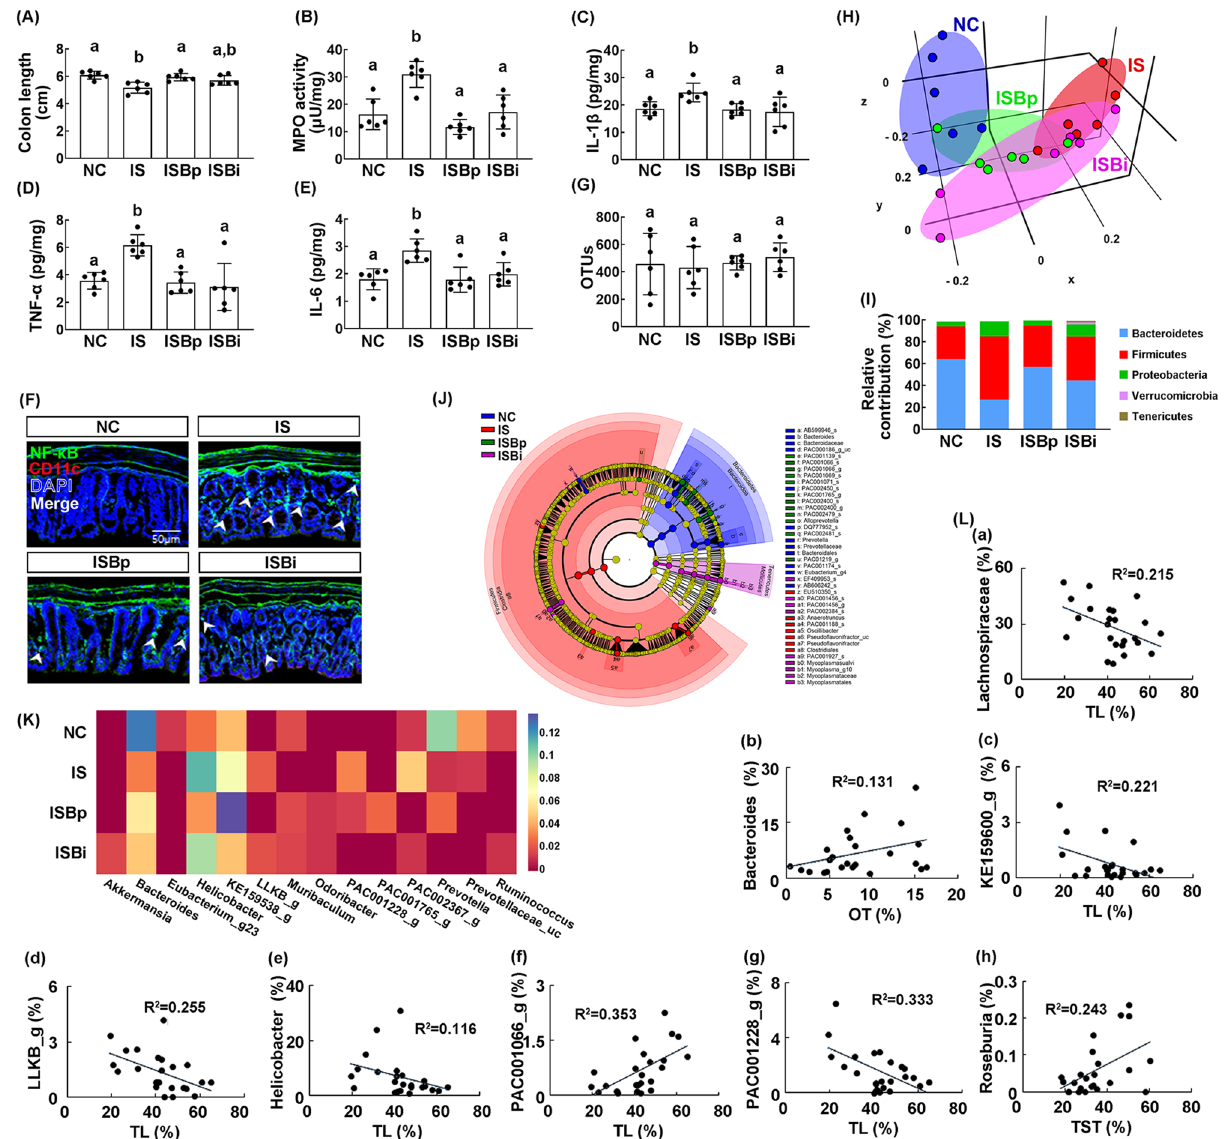
Figure 2. Orally gavage or intraperitoneal injection of buspirone alleviated immobilization stress (IS)-induced colitis and gut microbiota pertubation in mice. Effects on IS-induced colon shortening ( A ), myeloperoxidase (MPO) activity ( B ), IL-1β ( C ), TNF-α ( D ), and IL-6 expression ( E ), and NF-κB + /CD11c + cell population ( F ) in the colon. Effects on the composition of gut microbiota: estimated operational taxonomic units (OTUs) ( G ), principal coordinate analysis (PCoA) plot ( H ) based on generalized UniFrac analysis. Composition of gut miciobiota analyzed in phylum level ( I ). ( J ) Cladogram was generated by LEfSE indicating significant differences in gut microbial abundances among untreated control (NC, blue), IS-treated (IS, red), orally buspirone-treated (ISBp, green), and intraperitoneally buspirone-treated (ISBi, purple) groups. Yellow nodes represent species with no significant difference. The threshold logarithmic score set at 3.5 in the family level and ranked. ( K